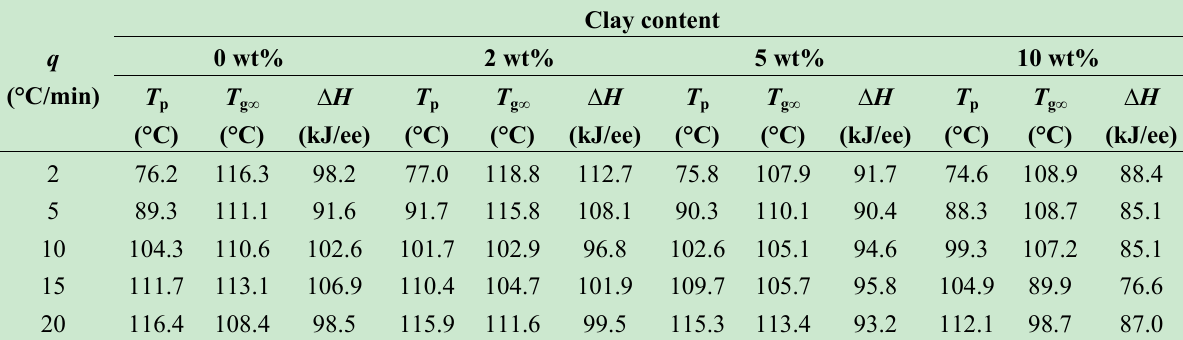
Table 3. DSC results for non-isothermal cure of nanocomposites cured with HBP at the indicated heating rates, q : T is the temperature for maximum heat flow; T p transition temperature of the fully cured sample and ∆ H is the total heat of the reaction.